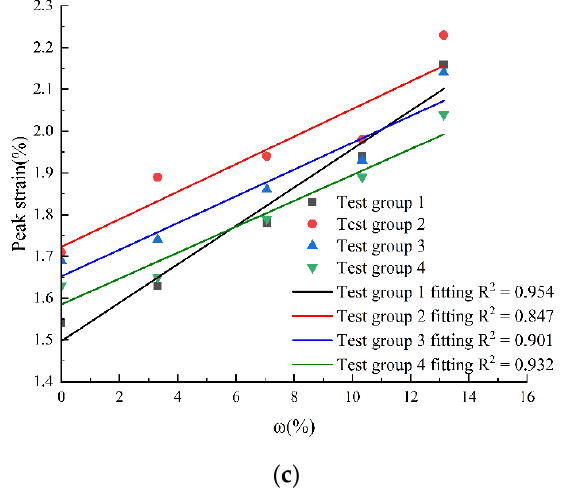
Figure 7. The fitting curve of mechanical parameters and moisture content of coal samples: ( a ) uniaxial compressive strength; ( b ) Young’s modulus; ( c ) peak strain.